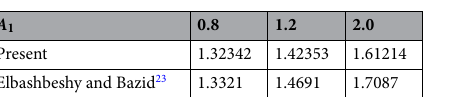
Table 2. Comparison of present results with previously published